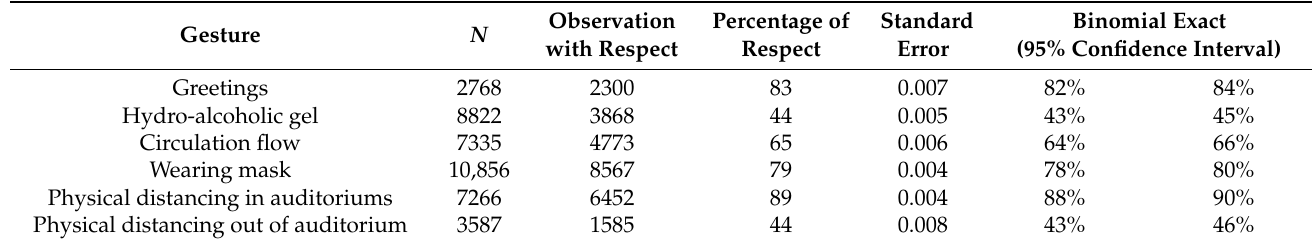
Table 3. Observed percentage of barrier gesture implementation and confidence interval.